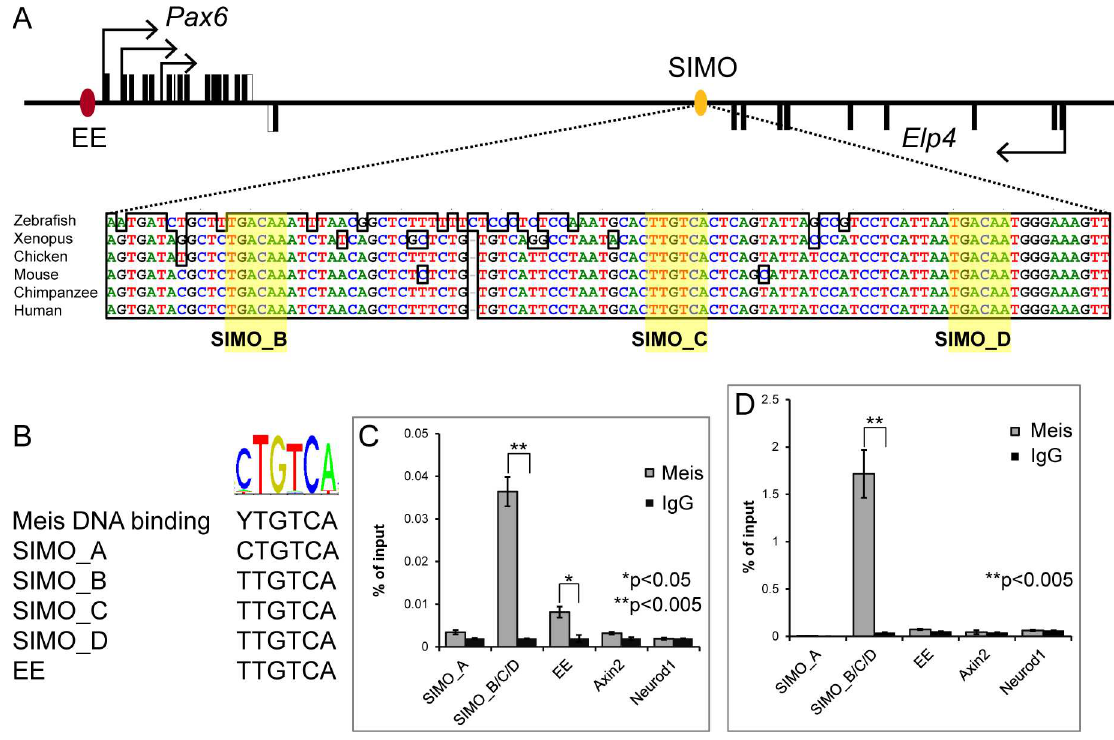
Fig 3. Meis proteins bind SIMO element of Pax6 in vivo . ( A ) Schematic representation of the Pax6 locus, displayingthe exons of Pax6 (black boxes, top strand) and adjacent Elp4 gene (black boxes, bottom strand). Ectoderm enhancer(EE) is indicatedwith red oval; SIMO enhancer is indicatedwith yellow oval. The detail of the part of the SIMO shows high conservation across the vertebrate species.In SIMO, five putative Meis bindingsites were identifiedwith three, SIMO_B, SIMO_C and SIMO_D (indicatedwith yellow color), clusteredin highly conservedpart of the SIMO enhancer.( B ) The nucleotidecomposition of selectedputative Meis bindingsites found in SIMO and their comparisonwith Meis consensus bindingsite and previously identifiedMeis bindingsite in EE. ( C , D ) Results of chromatinimmunoprecipitationof Meis-bound DNA fragments performed with the mixture of Meis1-specific and Meis2-specific antibody on chromatinpreparedfrom E10.5 whole embryos( C ) or α TN4 mouse lens epithelialcells ( D ) showingclear enrichment on SIMO enhancer.( C, D ) Error bars denote SDs, * p and ** p versus control using Student’s t